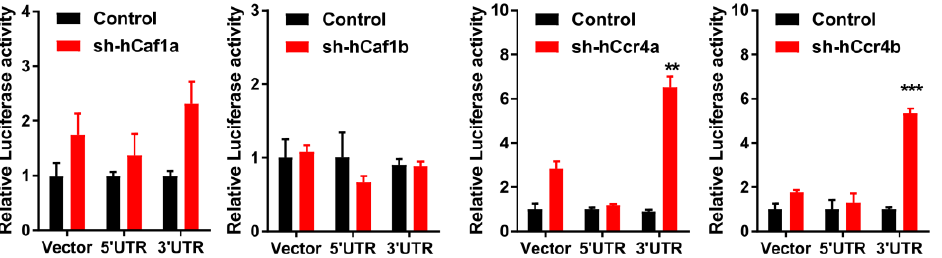
Figure 6. Effects of hCcr4a/b- or hCaf1a/b-knockdown on luciferase activity driven by the promoter, 5’ -UTR, or 3’ -UTR of p21 in the MKN28 cells ( n = 3). ** p < 0.01, and *** p <